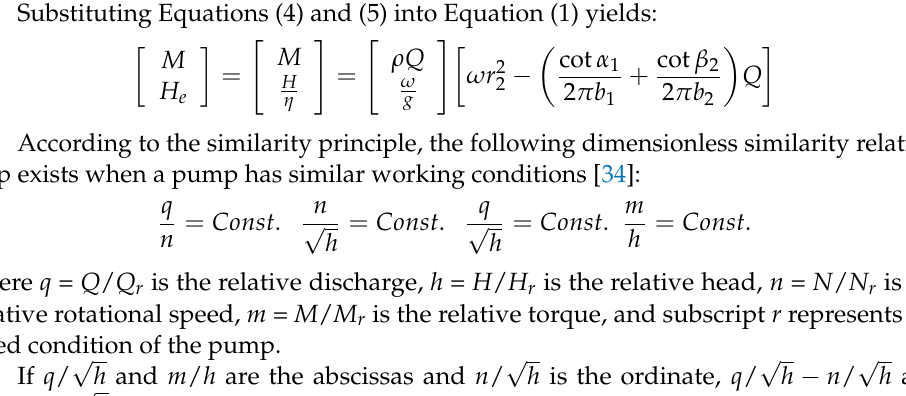
Figure 1. The velocity triangles at the impeller of a centrifugal pump.